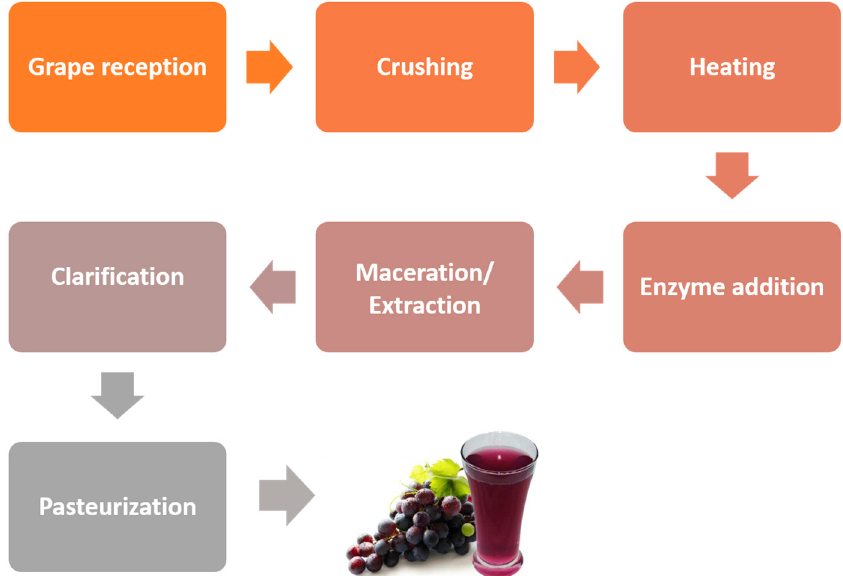
Figure 1. Simplified grape juice flow diagram of hot pressing.